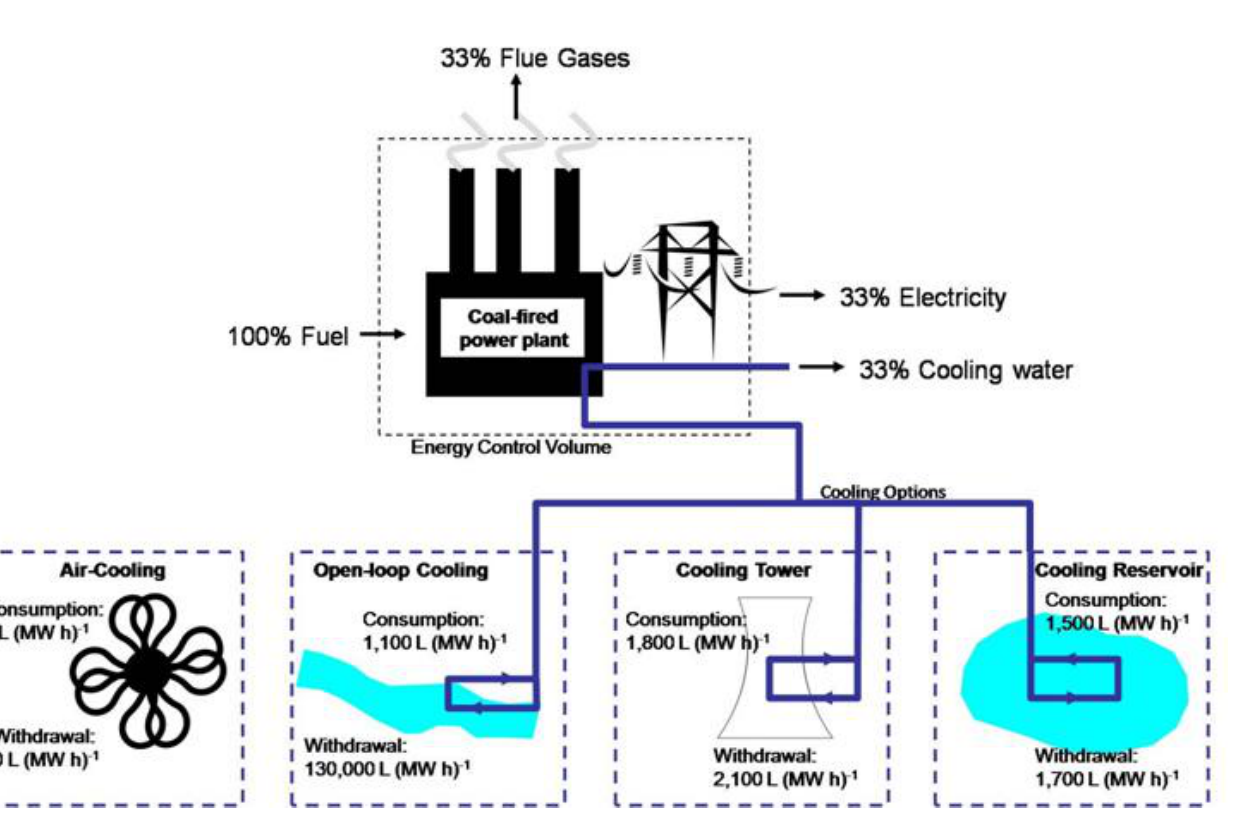
Fig. 4 . Basic schematic of a pulverized coal-fired power plant with percentages of energy flow and median water withdrawal and consumption for cooling per megawatt-hour (MWh) of electricity generated (Goldstein and Smith 2002a, Masters 2004). Only 33% of the incoming fuel is converted to